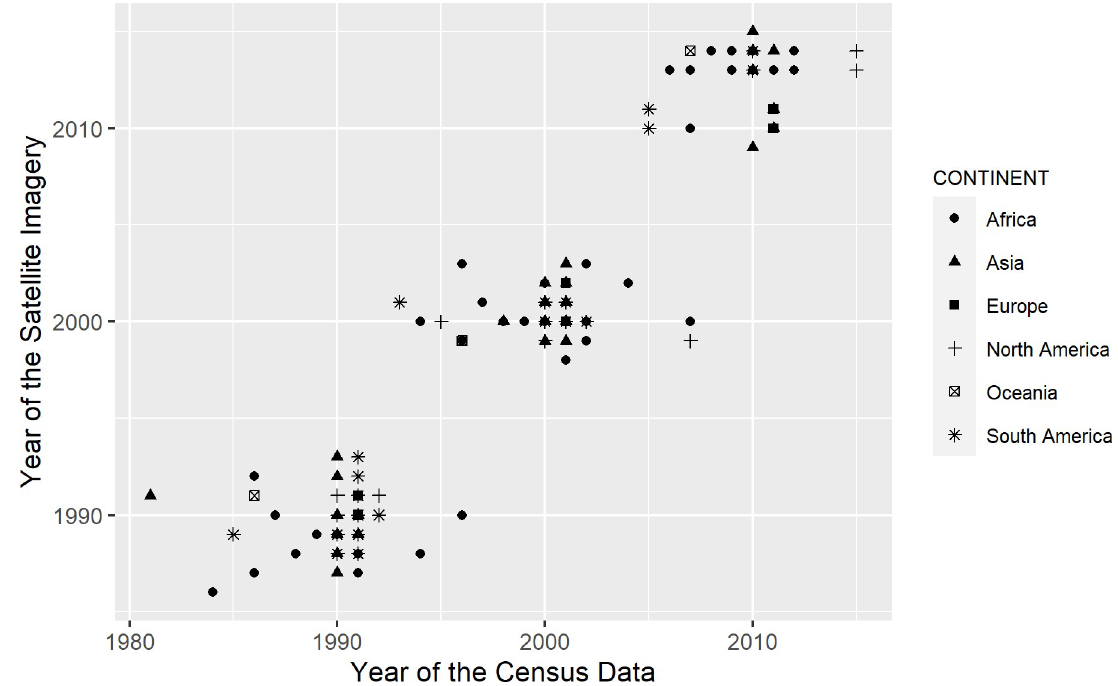
Fig 3. Comparison between the year of IPUMS and AUE data